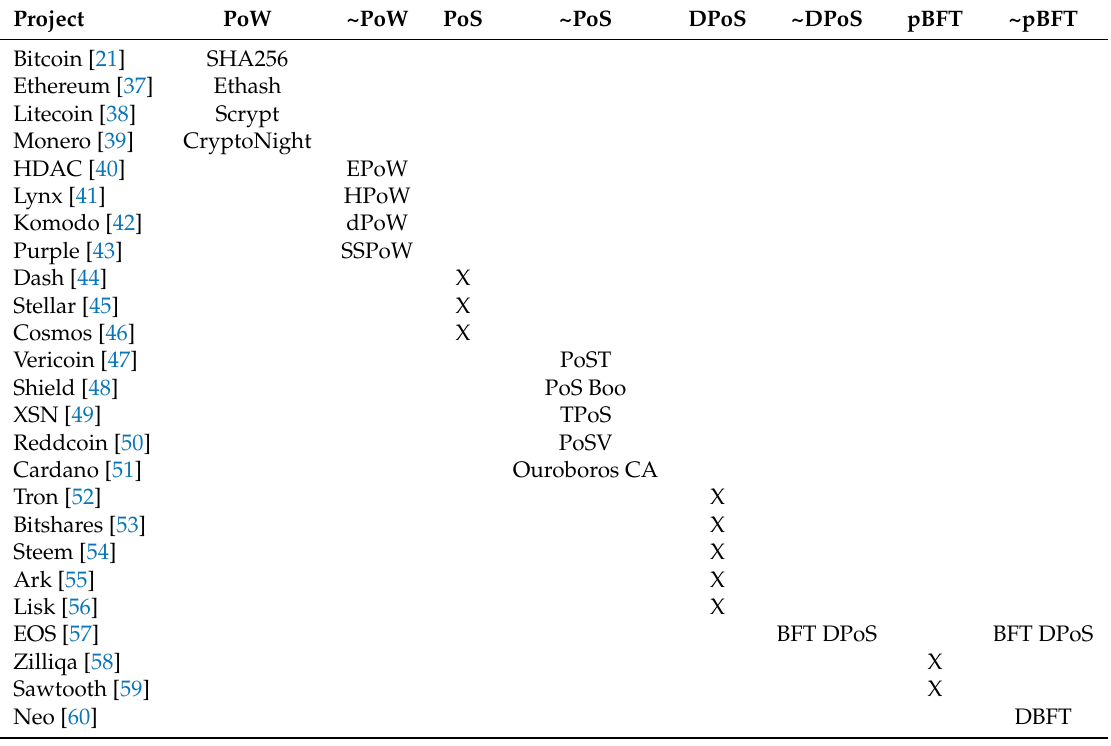
Table 3. Popular Blockchain consensus